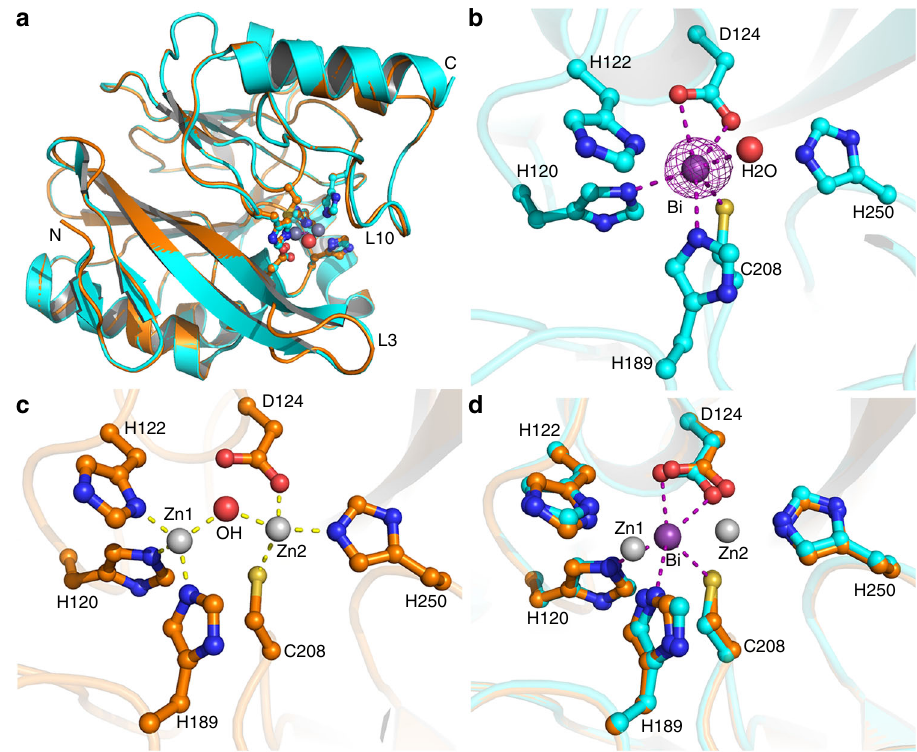
Fig. 3 Crystallographic analysis reveals the binding mode of Bi(III) in the active site of NDM-1 a Superimposition of Bi-bound NDM-1 (cyan) with native Zn- bound NDM-1 (orange). Structural alignment was done over C α residues using SSM algorithm in Coot and the images were generated using PyMOL. The two structures can be superimposed well with a rmsd value of 0.18 Å. b The active site of Bi-bound NDM-1 with the anomalous density peak of Bi shown in purple mesh contoured at 15.0 σ . c The active site of native Zn-bound NDM-1 with two Zn(II) ions shown as gray spheres and the bridging hydroxyl nucleophile as a red sphere. d An overlay image comparing the relative position of Bi(III) (purple sphere) with the two Zn(II) ions (gray spheres). Bi(III) is located in between the two Zn(II) ions slightly closer to Zn (Fig. 4f). For the monotherapy, CBS failed to protect any of the